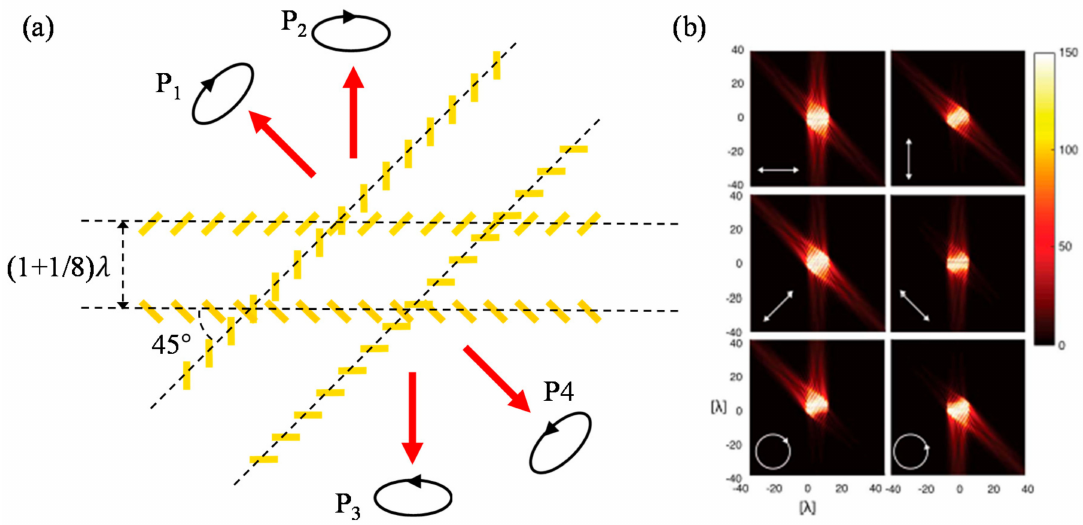
Figure 15. ( a ) Unit cell scheme of polarimeter designed by Muller et al. [171] ( b ) presents far-field scattering in case of the six distinct polarizations, which are described with the white arrows in the plots. From Reference